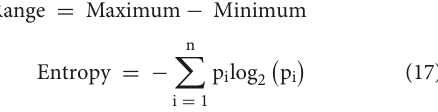
and the compensated images, we can see that the gradual change of illumination in the original image has been corrected to a large extent on the bottom.